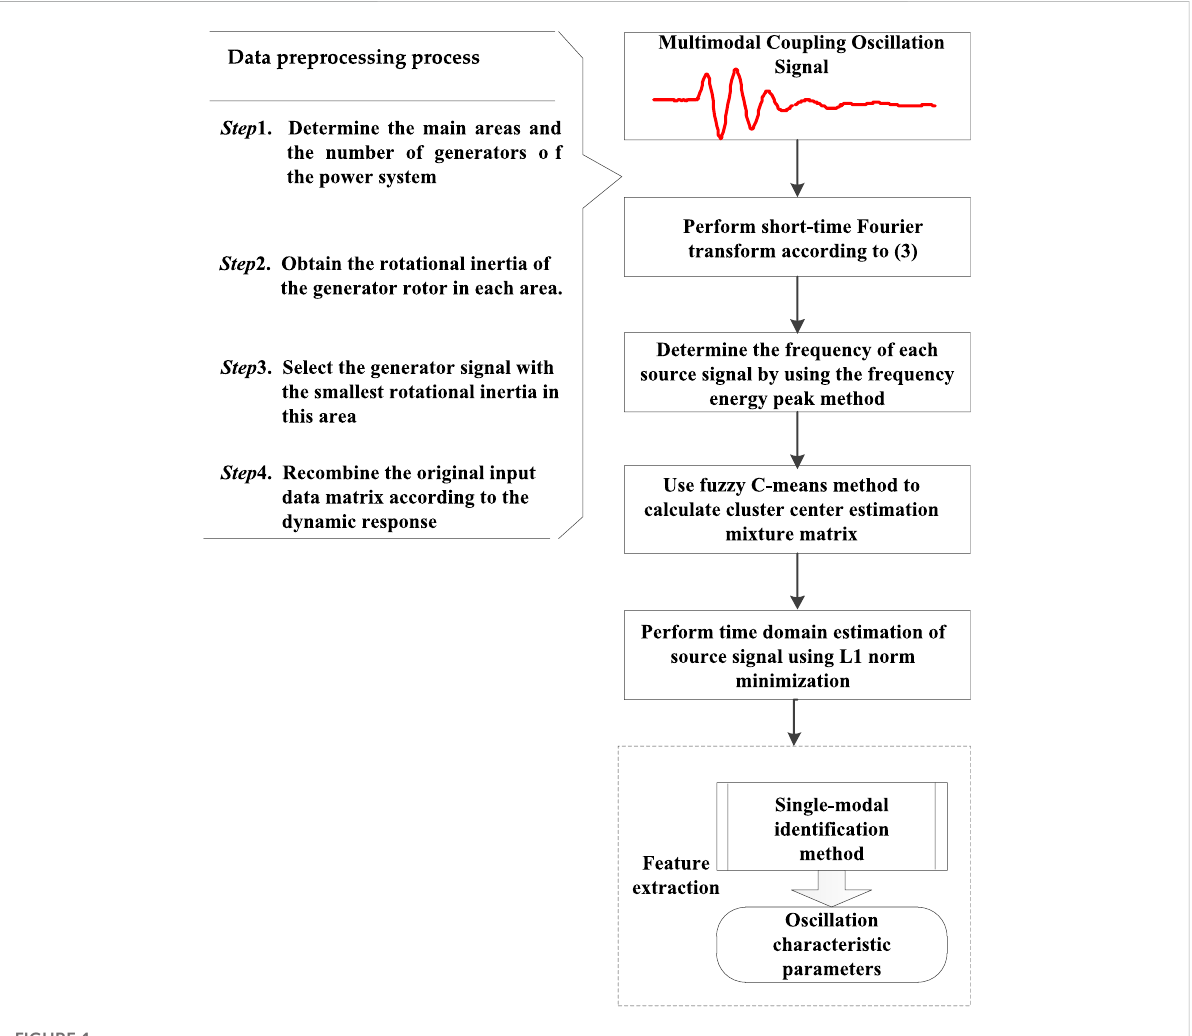
FIGURE 1 Flow chart of SCA and the modal parameter identi fi